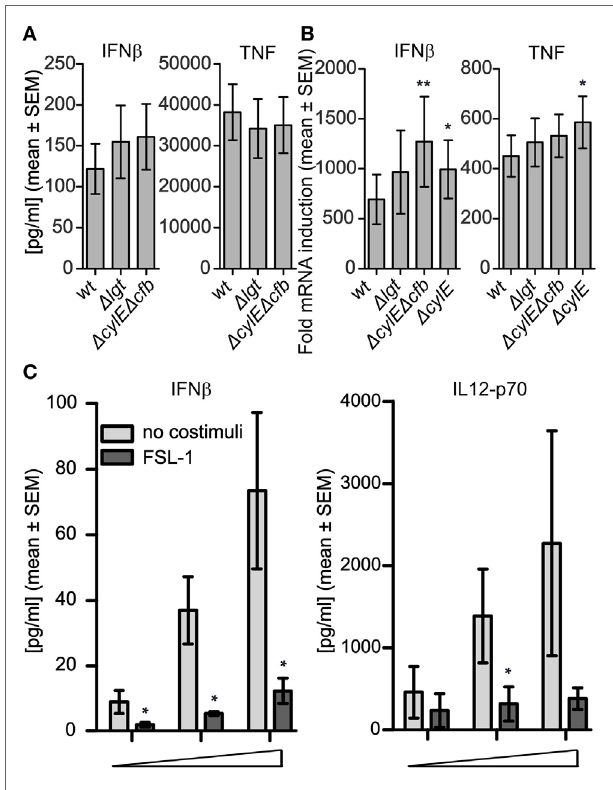
FigUre 1 | Group B Streptococcus (GBS) induce IFN β and TNF via a TLR2-independent mechanism and is a more potent trigger than Staphylococcus aureus from stationary growth. Human primary monocytes (Mo) and monocyte-derived macrophages (MDM) were infected with viable GBS wt, lipoprotein diacylglyceryl transferase deficient GBS ( Δ lgt ) and S. aureus 113-strain. Cytokine induction was determined by quantitative real-time PCR (qPCR) 3 h postinfection in monocytes (a–c) [multiplicity of infection (MOI): 0.4–4.0 for S. aureus , and 0.2–2.0 for GBS], or 4 h postinfection in MDM (D) (MOI 4.0–40 for S. aureus and 2.0–20 for GBS). Statistical significance was tested relative to S. aureus. n = 4.